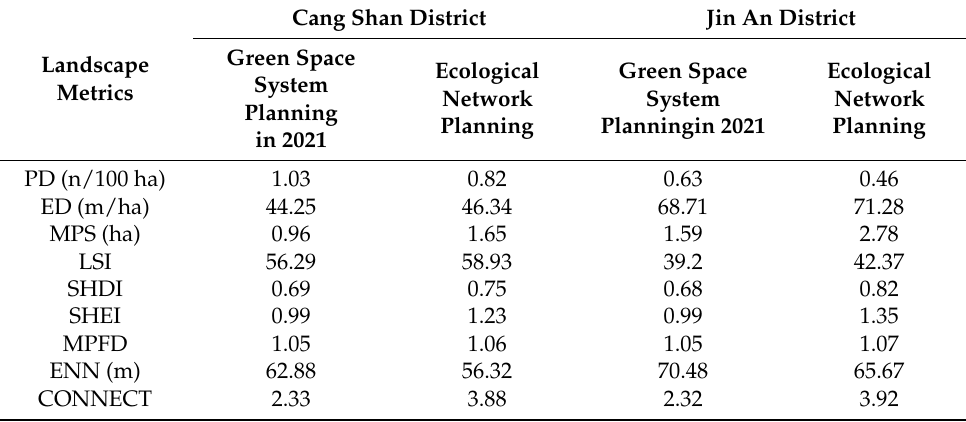
Table 10. Landscape metrics in different plans of Cang Shan and Jin An